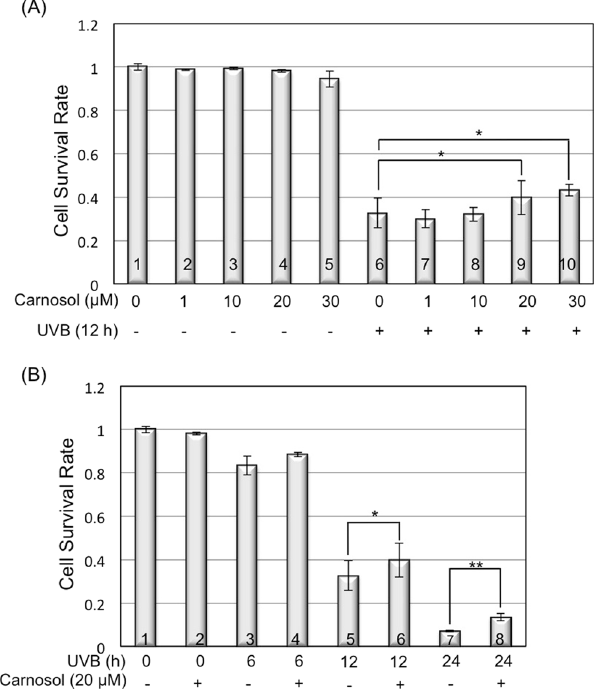
Figure 6. Carnosol protects UVB-induced cell death. Cells were exposed to UVB radiation with different doses of carnosol treatment. At indicated time point, cells were collected and Annexin V/PI apoptosis detection kit was used to detect cell apoptosis. ( A ) HaCaT cell survival rate with different concentrations of carnosol treatment at 12 hours post UVB radiation. ( B ) Time dependent assay in the presence or absence of carnosol treatment in HaCaT cells. * p < 0.05, ** p <